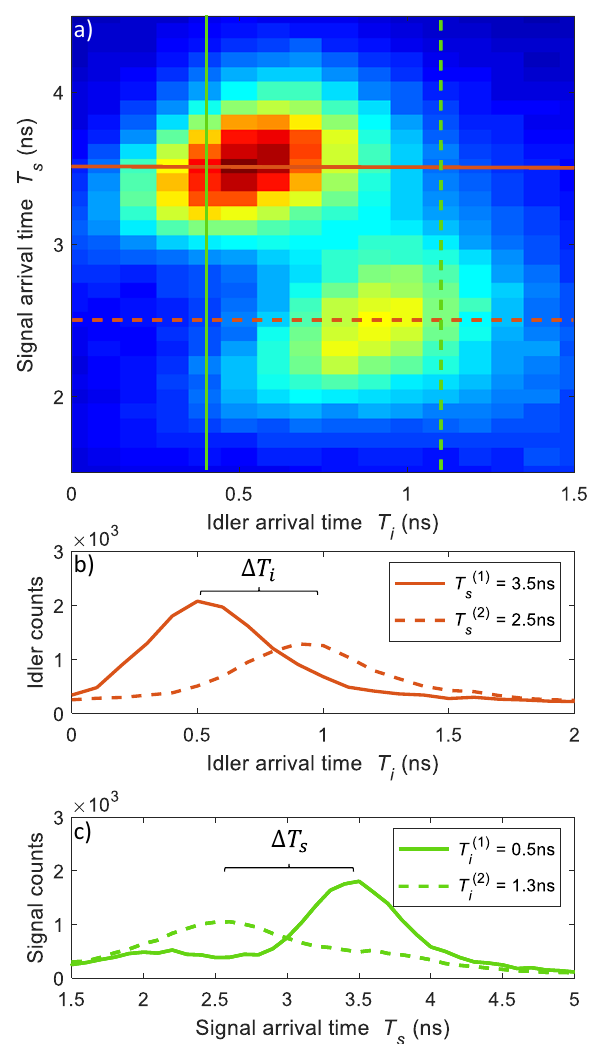
Fig. 2 Temporal two-photon probability. a Histogram of the arrival times T s , T i of the signal, and idler photons. The arrival times are measured relative to an electronic trigger from the pump laser which serves as a global clock, and after adding an electronic delay of 70 ns to the idler detector to compensate for the chromatic delay between the signal and idler photons. The two off-diagonal peaks indicate that the two-photon state is not separable. We, therefore, conclude that the photons are correlated in the modal basis. The two peaks correspond to the occupation of modes LP 02 j i LP 11 j i LP 11 j i , as veri fi ed by numerical computation of the fi ber ’ s s i modal group delays. b , c Cross-sections of the two-dimensional histogram along the lines marked in ( a ), emphasizing the modal correlations. For example, post selecting events with an idler ’ s arrival ¼ 0 : 4ns (green solid curve) shows localization of the time of T ð 1 Þ i signal photon at T ð 2 Þ s ¼ 3 : 5ns . In ( b ) the post-selection is on the signal photon, while in ( c ) it is on the idler photon. The measured delay between the two peaks is Δ T s = 1 ns for the signal photons and Δ T i = 0.5 ns for the idler